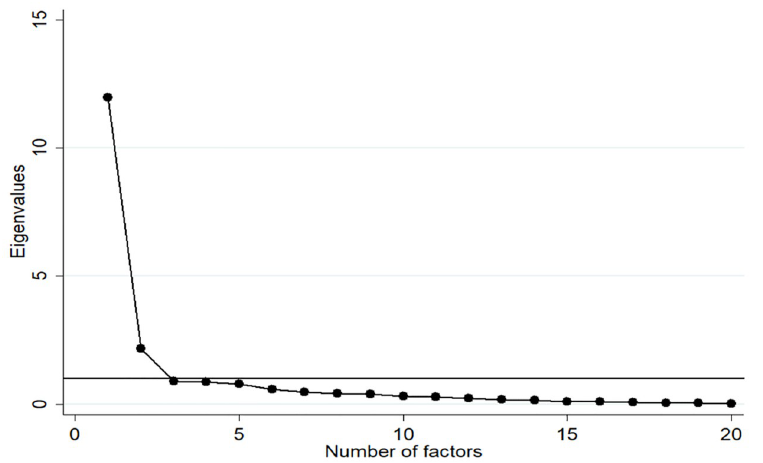
Fig 1. Scree plot for determining the numbers of factors